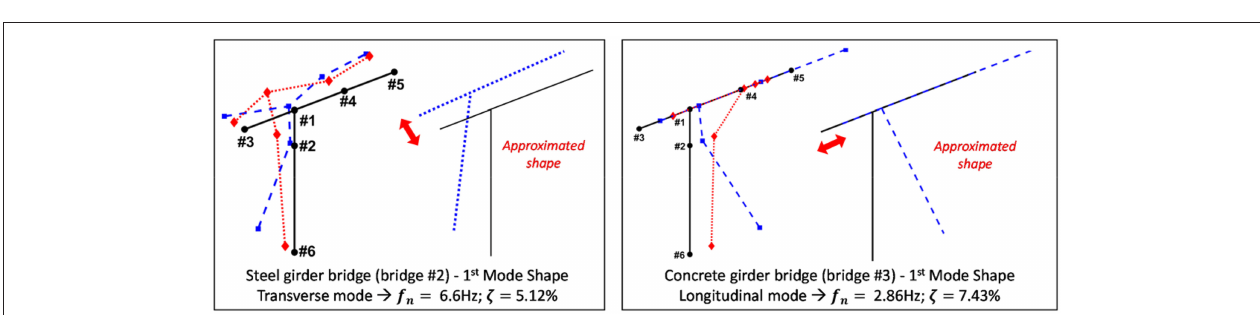
FIGURE 10 | Mode shape of the first mode obtained with SSI. Real (blue-square) and imaginary (red-diamond) parts of analytical mode shapes. Both parts are amplified by a factor of